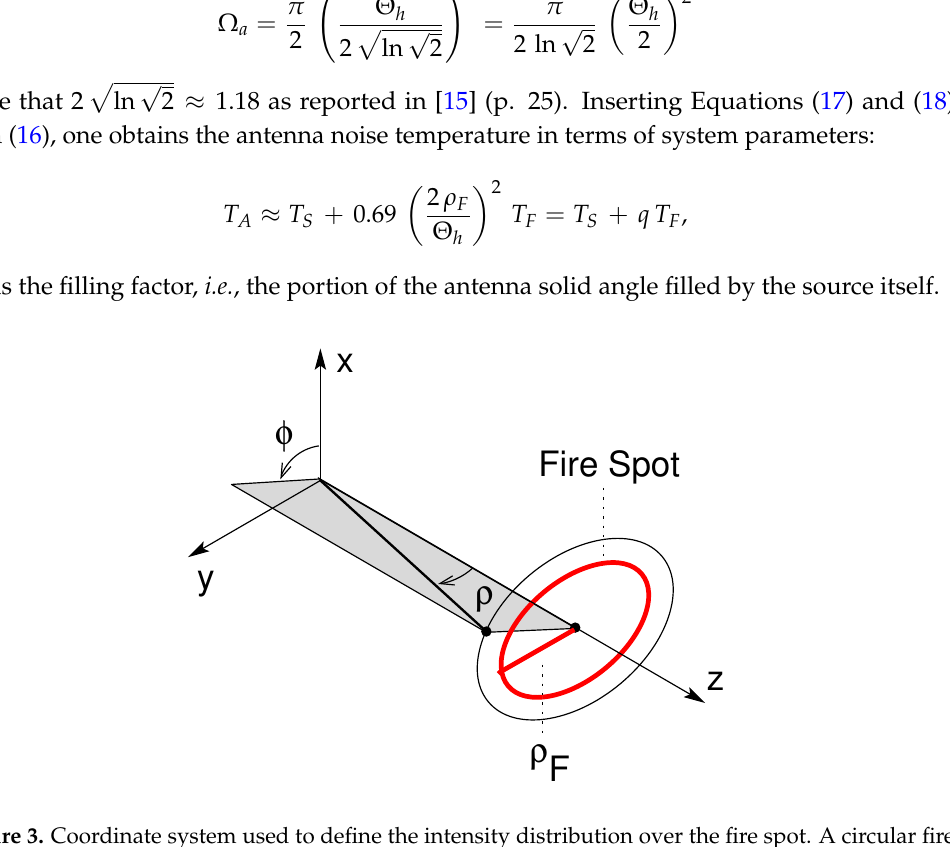
Figure 3. Coordinate system used to define the intensity distribution over the fire spot. A circular fire shape is assumed. The antenna is pointed toward the fire center.